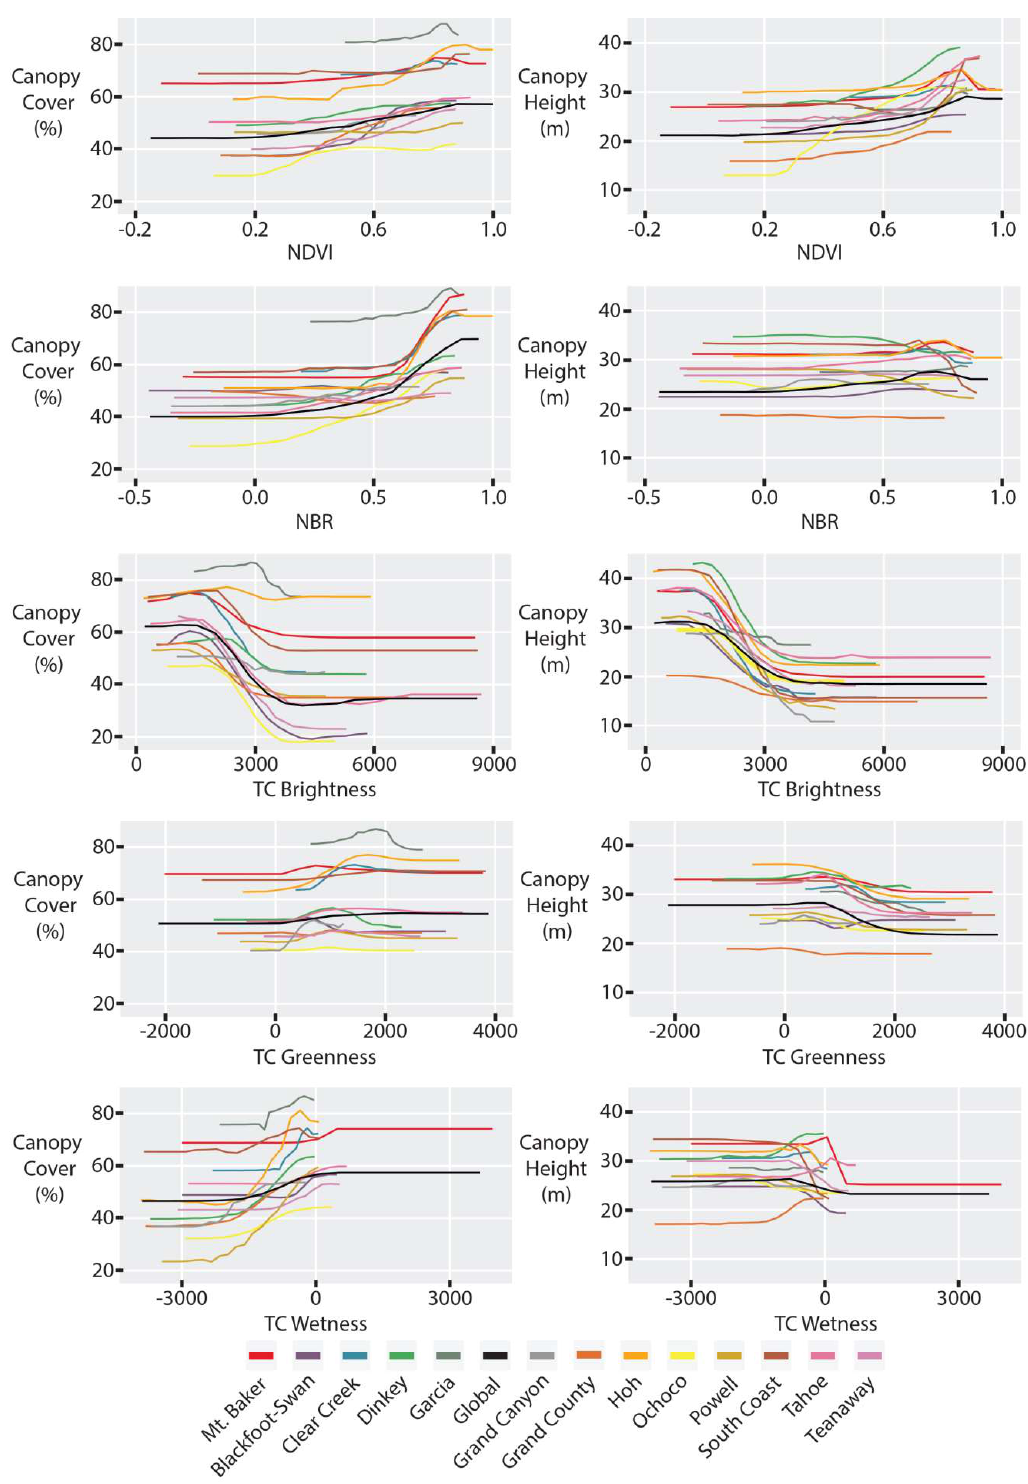
Figure 3. Partial dependence plots for each predictor variable ( x-axes ) and the canopy cover and canopy height response variables ( y-axes ). Each line shows the partial dependence using the local ( colored ) and global ( black ) landscape datasets.